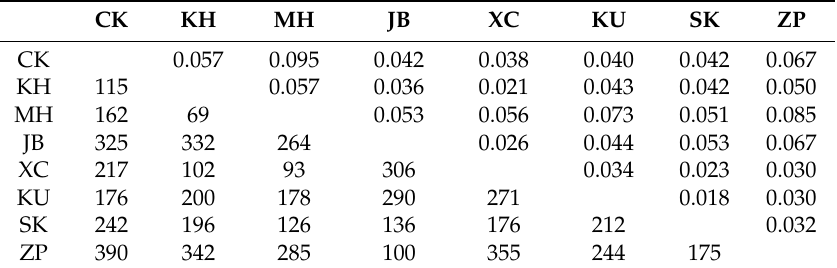
Table 3. Coefficient of genetic differentiation PhiPT ( Φ PT ) above diagonal and geographic distances (km) below diagonal for all pairwise comparison. All values of Φ PT are significant at a 0.001 level. Upper and lower values are in bold. For abbreviations of localities see Table 1.